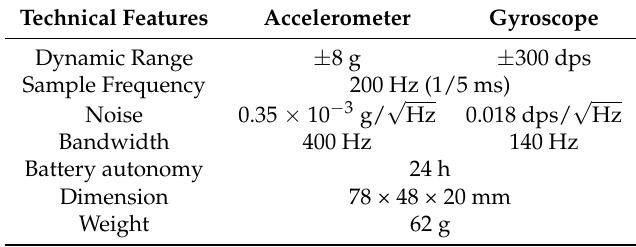
Table 2. Technical features of the inertial sensor G-Sensor2 (BTS Bioengineering, Milan,